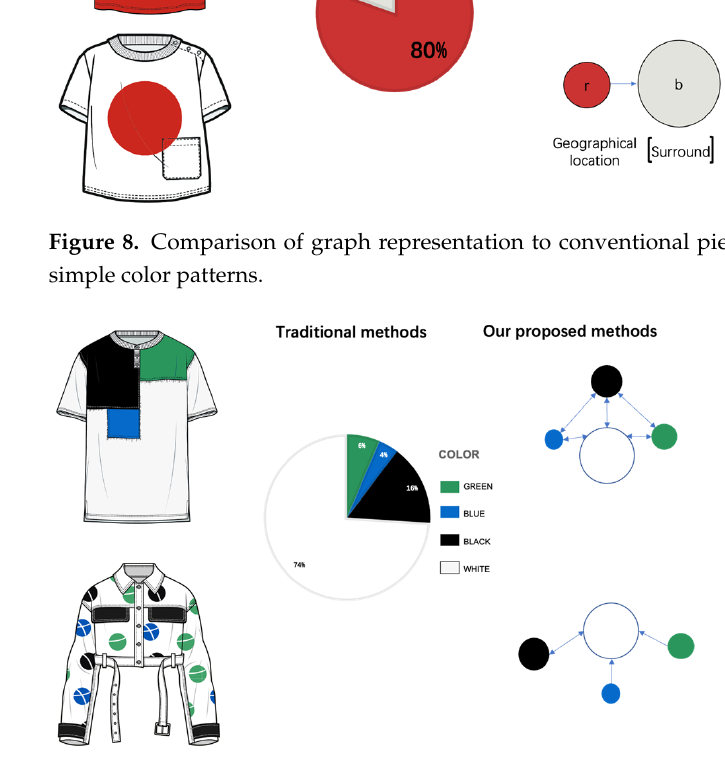
Figure 9. Comparison of graph representation to conventional pie chart for fashion outfits with complex color patterns.